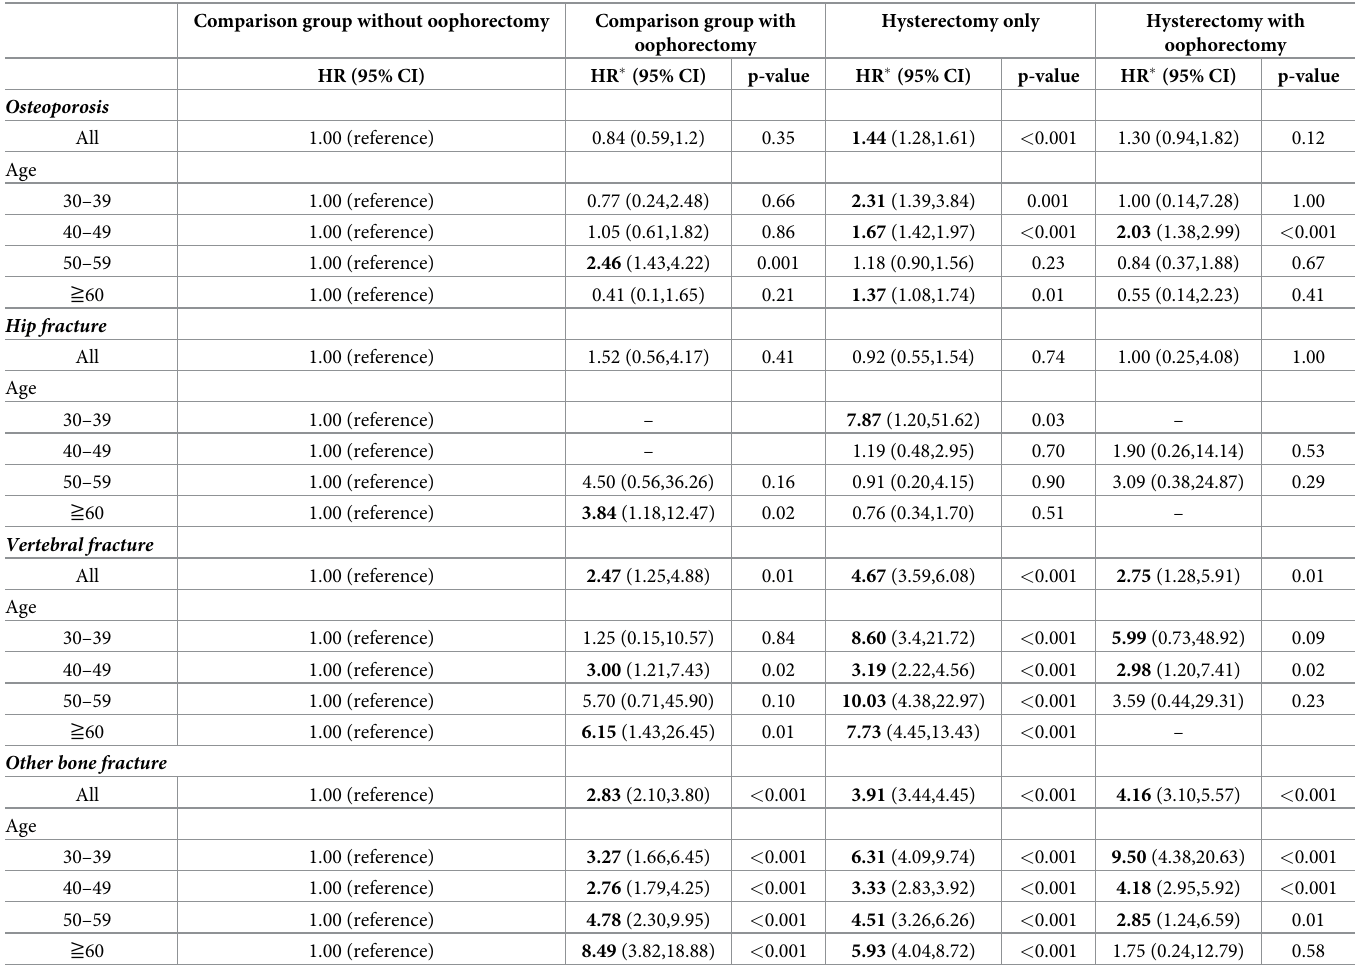
Table 3. Adjusted hazard ratio and 95% confidence interval of osteoporosis or fracture between women with hysterectomy or oophorectomy stratified by age. Comparison group without oophorectomy